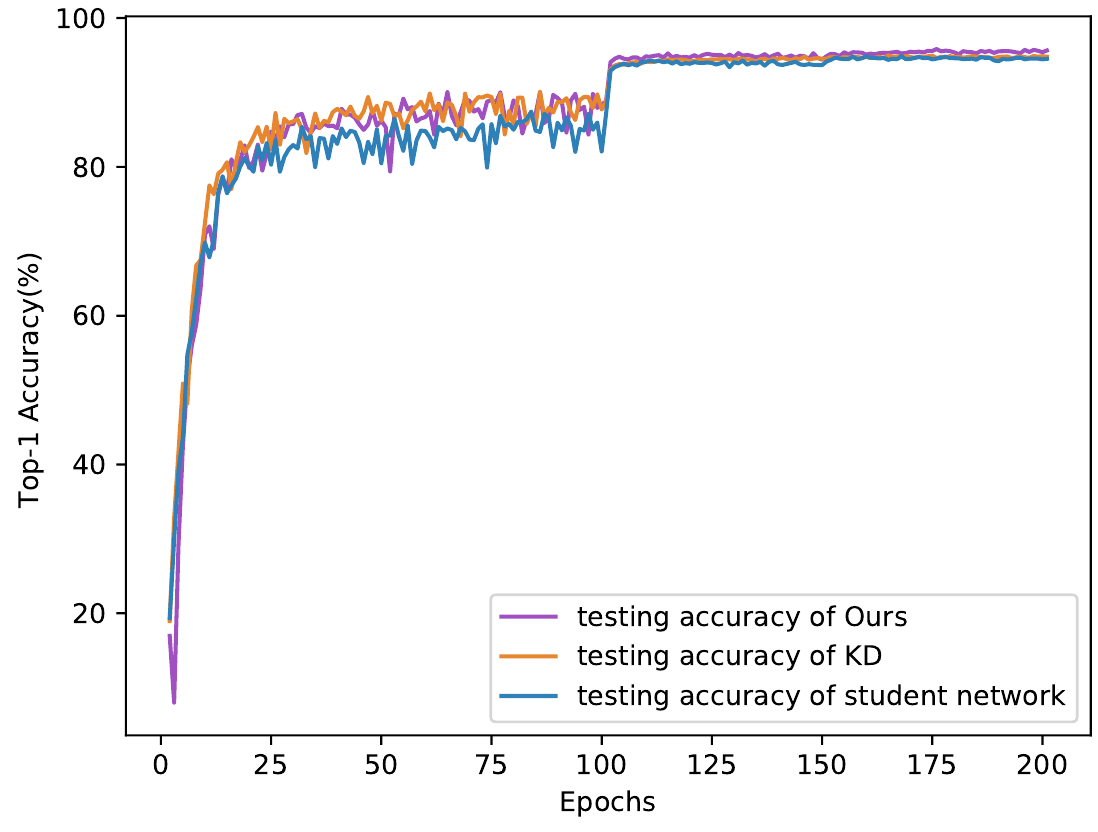
Figure 4. Testing accuracy on the NWPU-RESISC45 dataset, using different approaches. The training ratio is set as